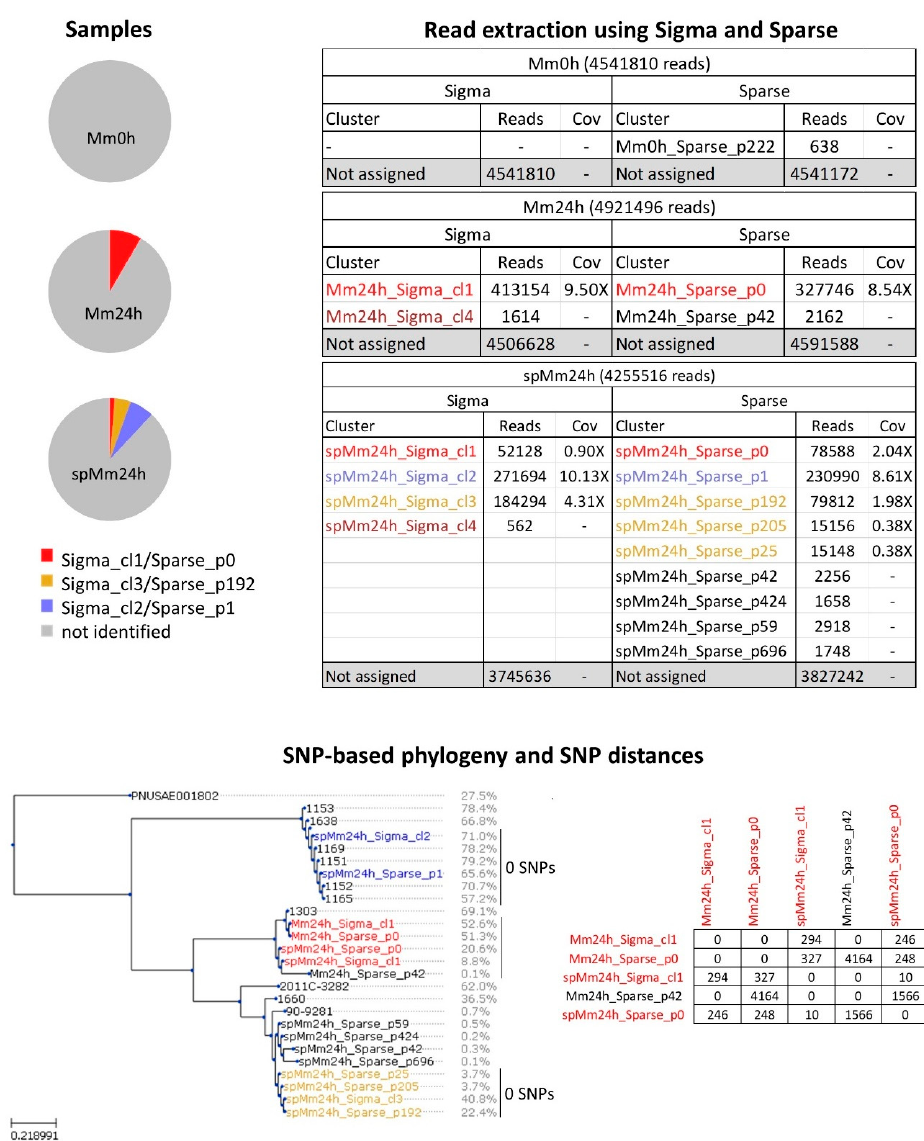
Figure 1. Strain-level metagenomic analysis of minced meat samples by Sigma and Sparse. Samples: the pie plots represent schematically the three metagenomic samples: the non-enriched minced meat sample containing no considerable endogenous E. coli strains (Mm0h), the enriched minced meat sample containing one more prevalent and one negligible (not included in figure) endogenous E. coli strain according to Sigma (Mm24h) and the minced meat sample spiked with isolate TIAC1152 and enriched containing three more prevalent and some negligible (not included in figure) E. coli strains, one of which (Sigma_cl2 / Sparse_p1) corresponds to the spiked strain (spMm24h). Read extraction using Sigma and Sparse: the tables show Sigma and Sparse clusters detected in Mm0h, Mm24h and spMm24h, along with the corresponding number of reads and coverage (Cov). Single nucleotide polymorphism (SNP)-based phylogeny and SNP distances: on the left, SNP-based phylogeny of Sigma and Sparse clusters detected in metagenomic samples (colored) and some background isolates (black, Table 1) is shown. Percentages listed next to the Sigma and Sparse cluster names and isolate names represent the fraction of the reference genome that was suitable for the phylogenetic analysis. On the right, SNP distances (expressed as SNPs per million of genomic positions) observed within some of the groups of closely related strains and isolates are indicated. The colors of the Sigma and Sparse clusters correspond to the colors used in Figure S2 and Figure 2, allowing to identify the section of the reference genome cgMLST tree from which the references underlying the clusters